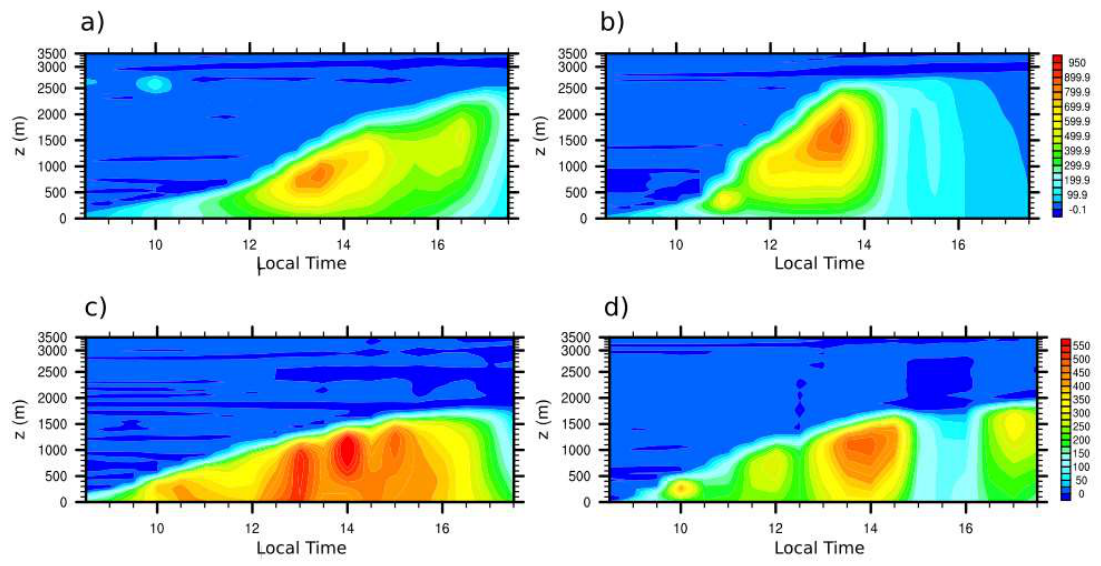
Figure 6. Time series of profiles of latent heat flux over: FOR ( a , c ); and PAS ( b , d ) sites. During: DRY ( a , b ); and WET ( c , d ) seasons.